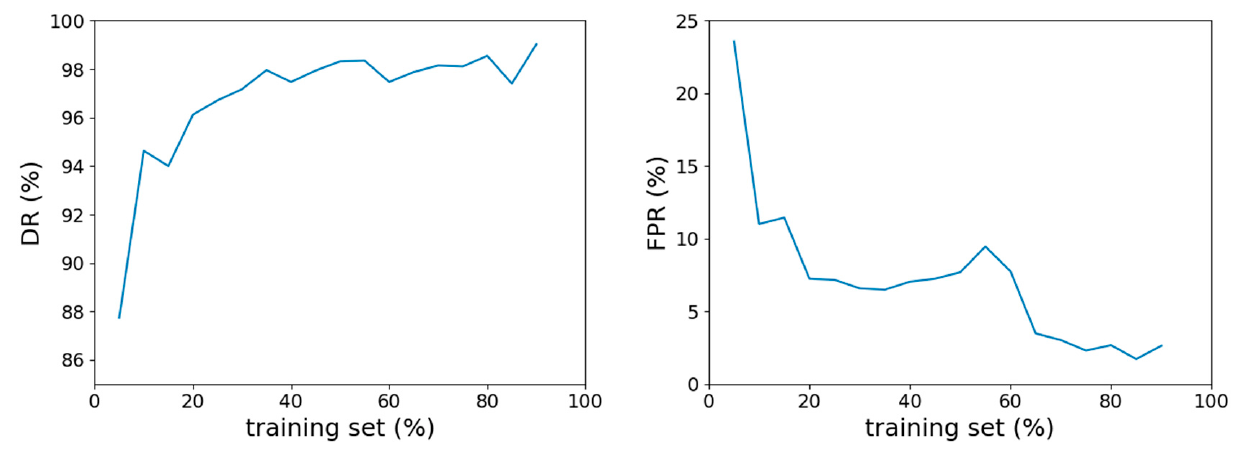
Figure 5. ( Left ) DR performances and ( Right ) FPR performances at different training set ratios for an average of 50 random users.